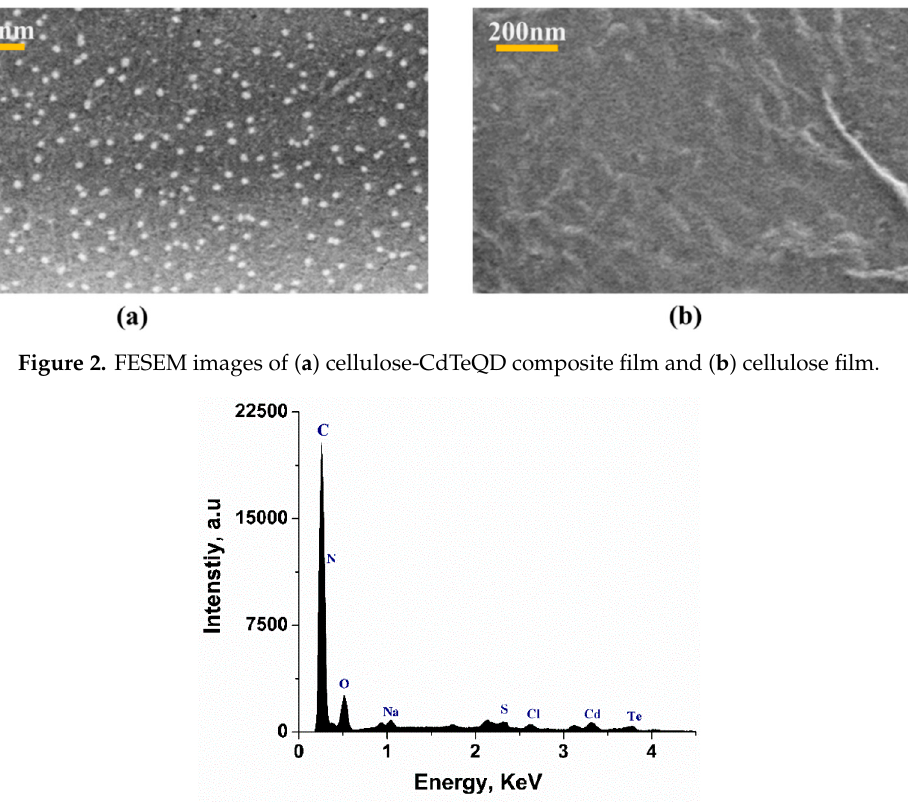
Figure 3. EDX spectrum of cellulose-CdTe QDs film.